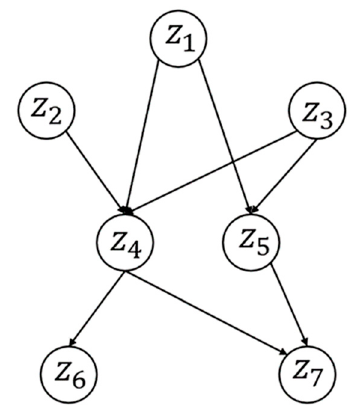
Figure 3. A typical Bayesian network.